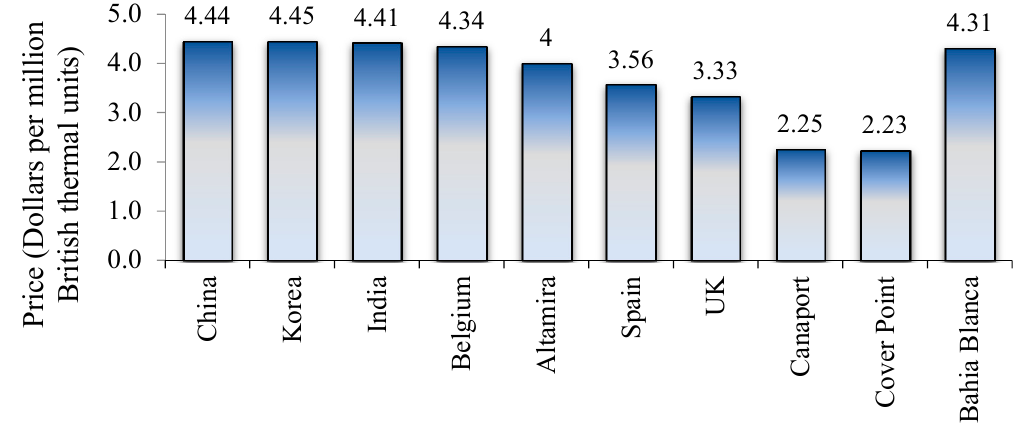
Figure 1. Worldwide landed price of liquefied natural gas (LNG) [13].